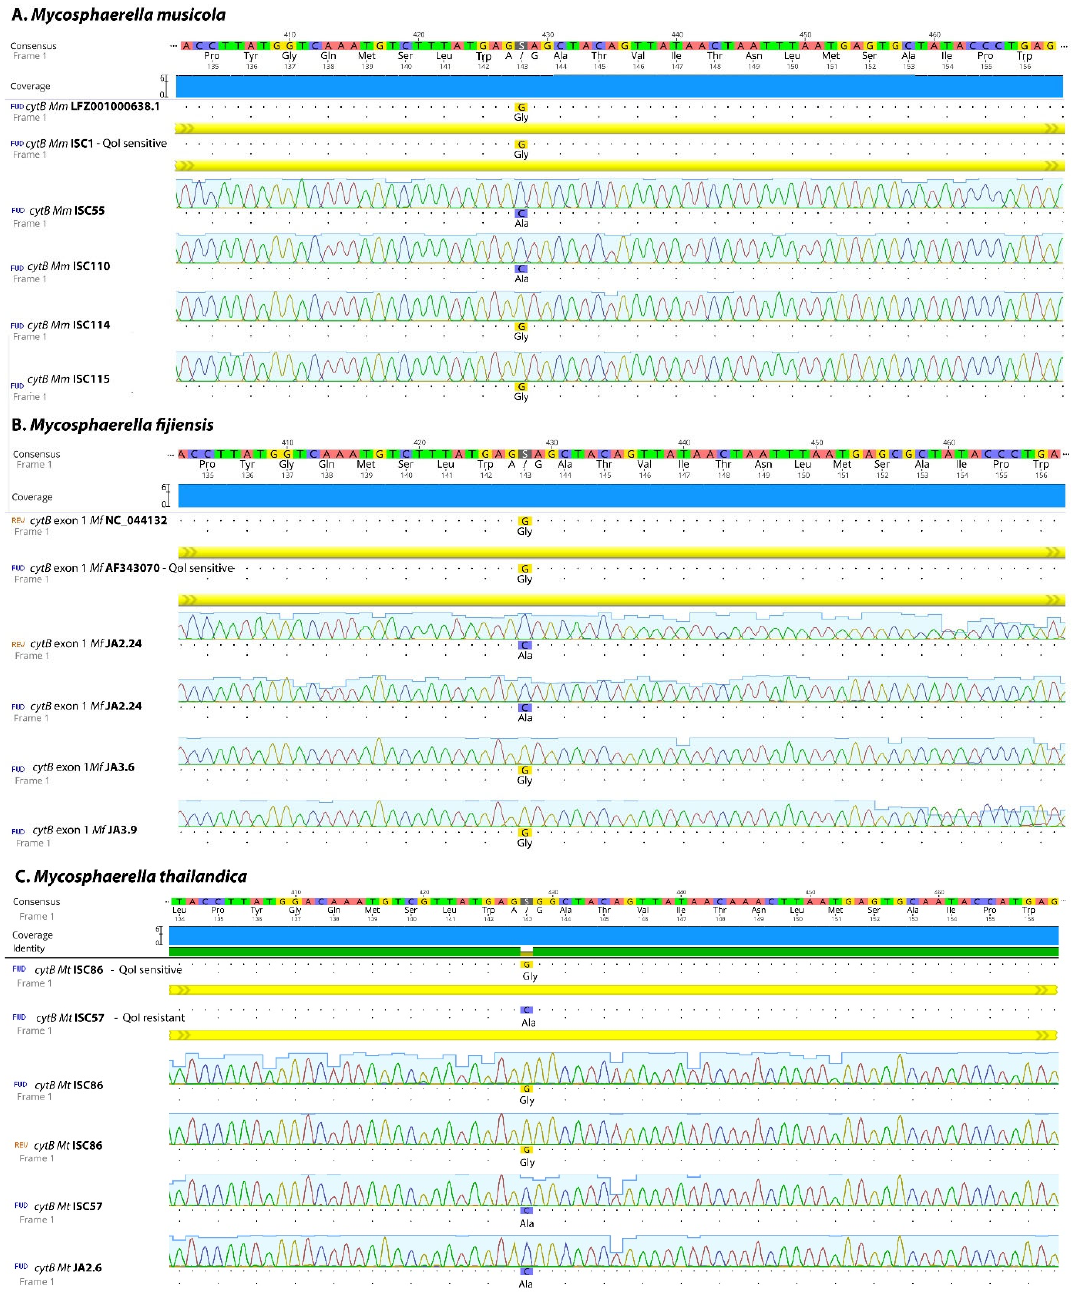
Figure 6. Graphical representation of the part of the cyt b gene from Mycosphaerella musicola ( A ), M. fijiensis ( B ) and M. thailandica ( C ) isolates containing the G428C mutation or not, resulting in the Gly143Ala amino acid substitution that confers resistance to QoI fungicides a, b, c . a Sequences from M. musicola aligned with the reference sequences LFZ01000638.1 and with Mm ISC1 sensitive to QoIs. b Sequences from M. fijiensis aligned with the reference sequences NC_044132 and with Mf AF343070 sensitive to QoIs. Because no cyt b sequences from Mt were available in the GenBank/NCBI we were able to align only among the experimental Mt cyt b sequences, from both QoI sensitive (ISC86) and resistant (ISC57 and JA2.6) isolates. c Fwd = forward sequence; Rev = reverse sequence. Looking at M. fijiensis (Table 5, Figure 6), the first cyt b Mf haplotype in exon-1 ( Hf1-1 ) is characterized by nine QoI-S strains, without non-synonymous mutation, but presenting an GA(TA)3 insertion at the 2058-bp position, distinct from the Mf sensitive reference